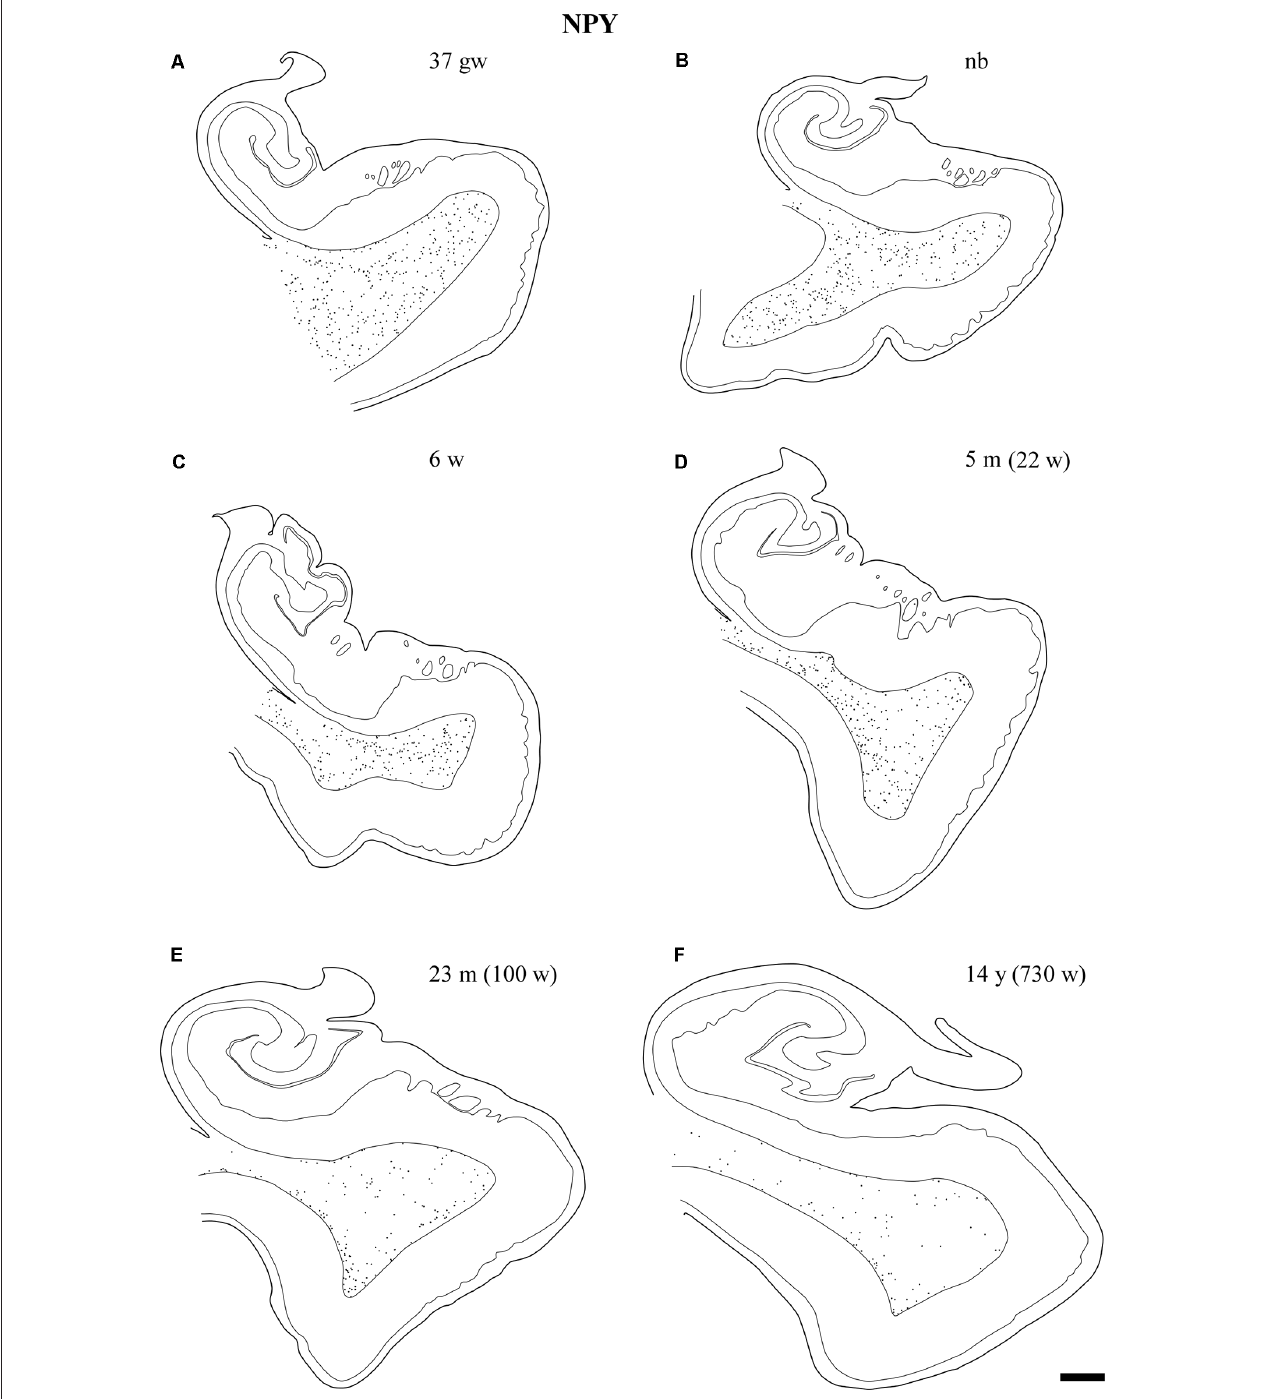
FIGURE 3 | Line-drawings (A–F) of the angular bundle white matter at midlevel of the hippocampus across ages in which NPY-positive neurons have been plotted. Individual neurons are represented by single dots. Other labeled neurons outside the angular bundle have not been represented. The age is indicated on each drawing. Note the decrease in the density of NPY-positive neurons with age. Scale bar is 2 mm.